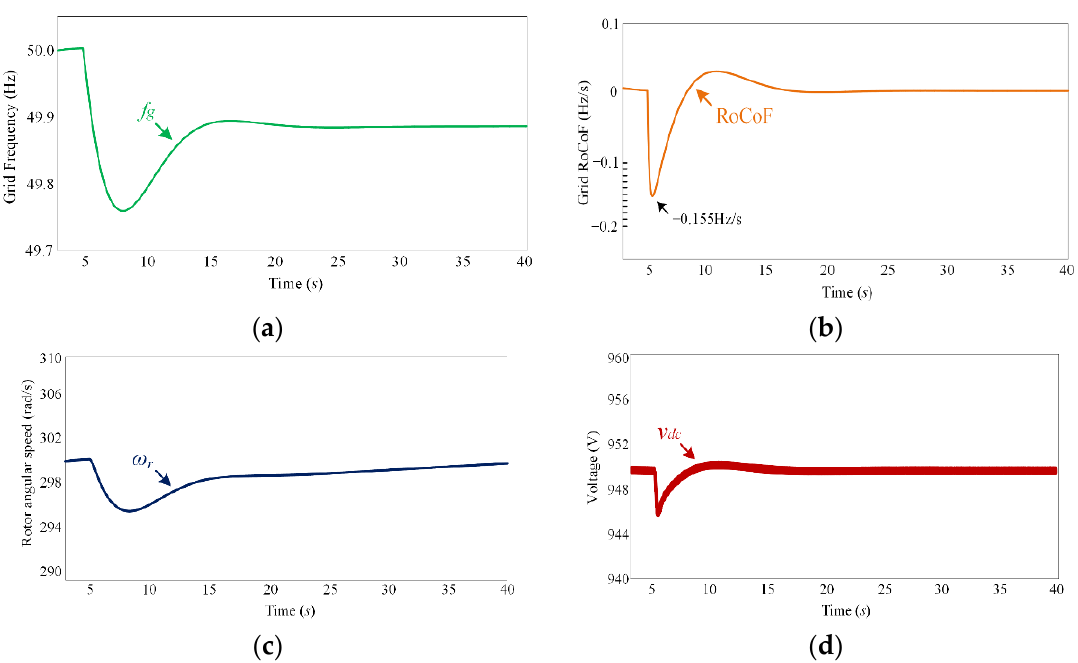
Figure 13. Simulation results when DFIG provides inertia support and the speed recovery control bandwidth is 0.03 Hz. ( a ) Grid frequency; ( b ) RoCoF; ( c ) rotor speed; ( d ) DC-link voltage.